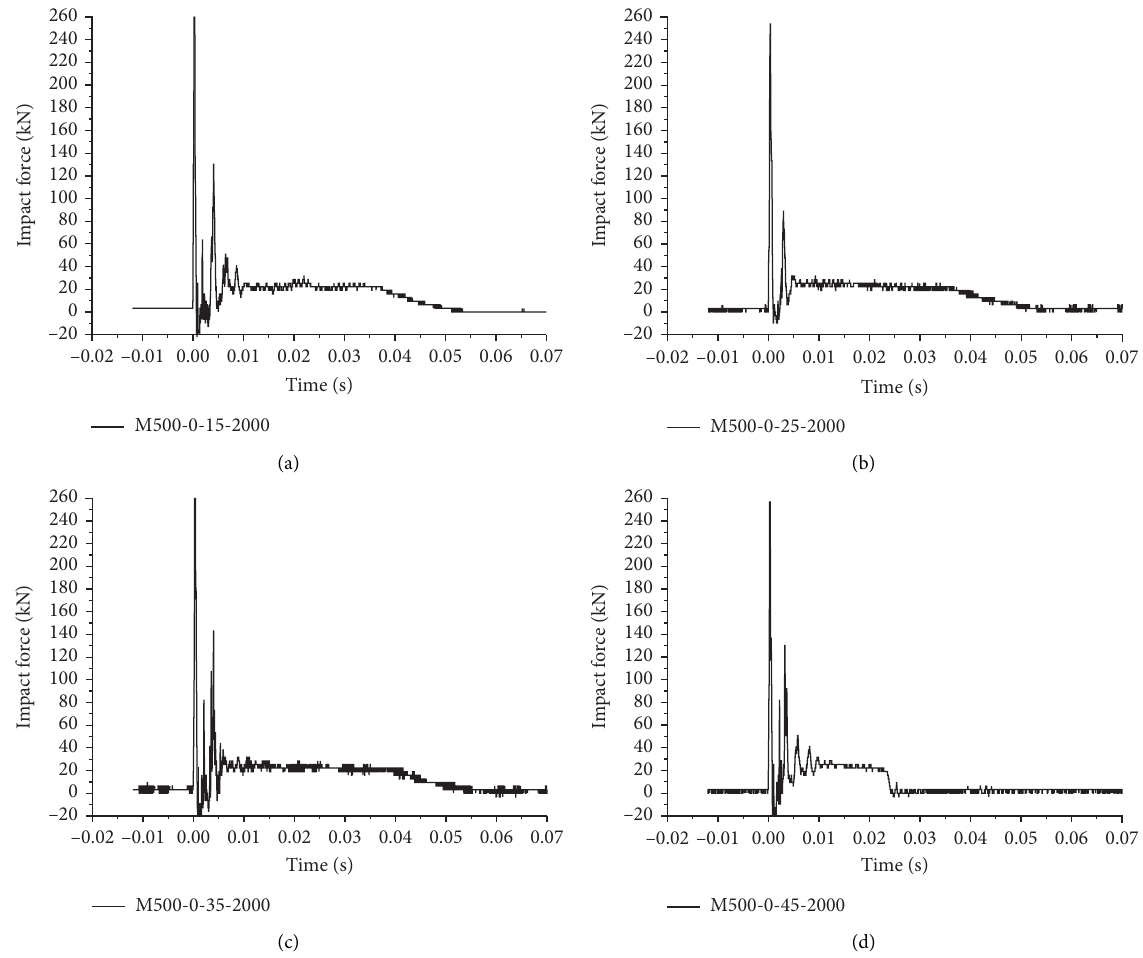
Figure 7: Time-history curves of bolted rock impact force under different prestresses. (a) M500-0-15-2000. (b) M500-0-25-2000. (c) M500- 0-35-2000. (d) M500-0-45-2000.